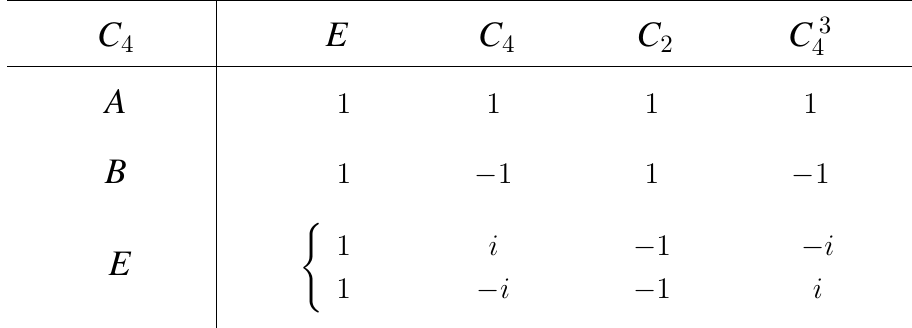
Table 1. Character table for the 4-fold rotational symmetry group ( C